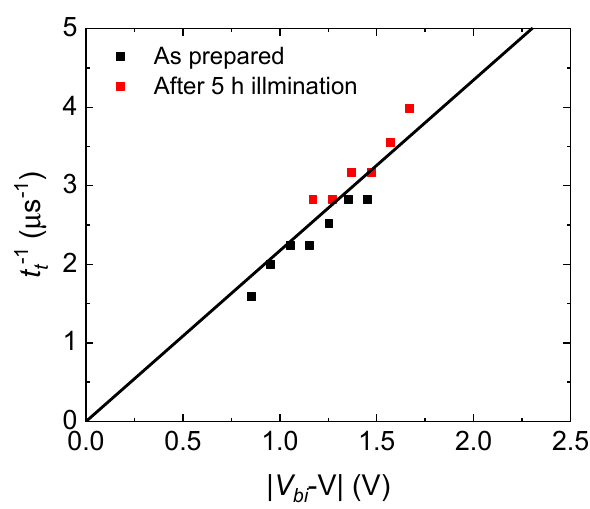
Figure 12. Effective applied voltage dependency of inverse transit times calculated from Figure 11 before and after 5 h of photoinduced degradation.